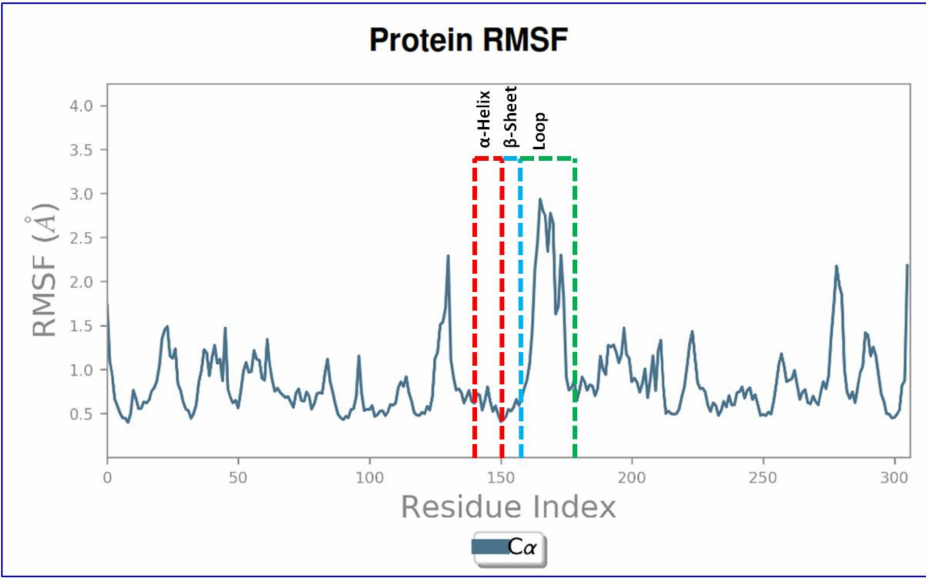
Figure 7. The Root Mean Square Fluctuation (RMSF) of Fts-Z protein (PDB ID-2VXY) throughout 100 ns molecular dynamic simulations showing local fluctuations along with the